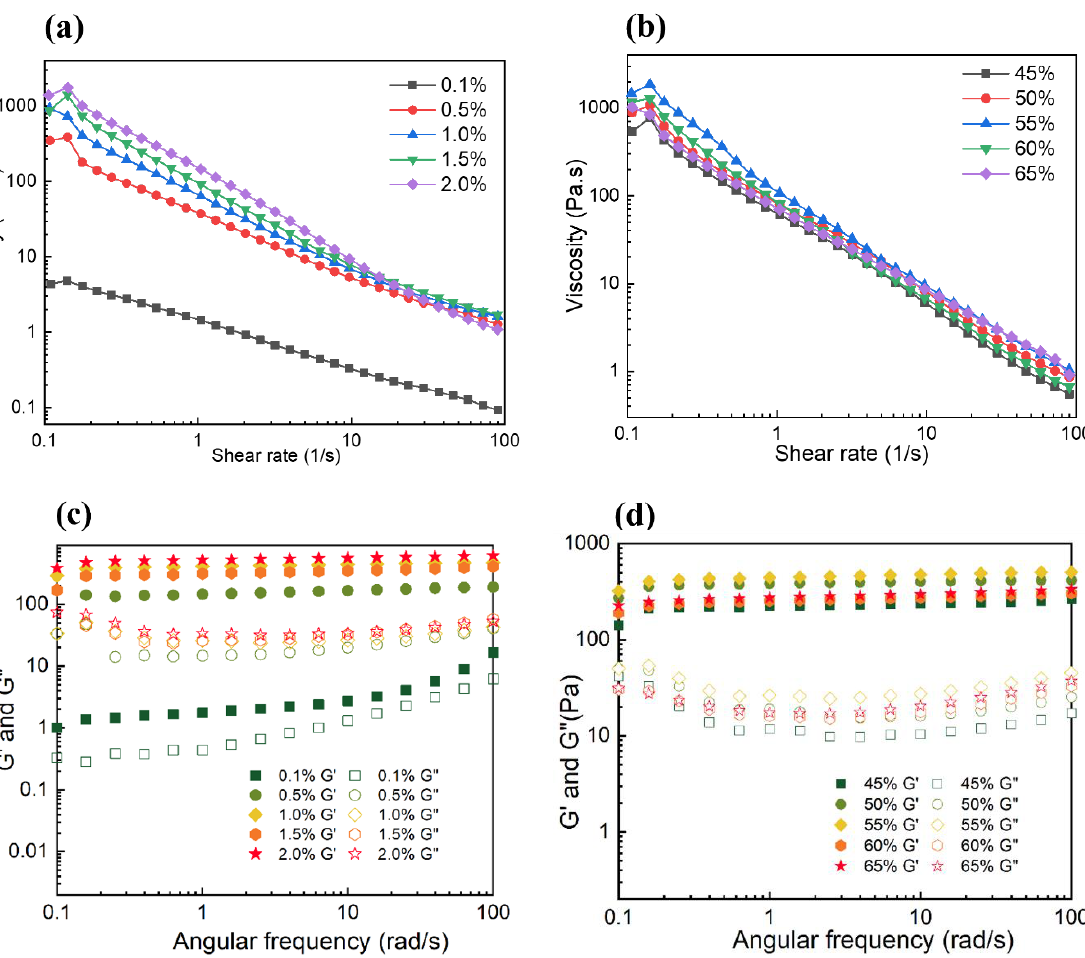
Figure 8. Apparent viscosity ( a , b ) and the dynamic rheological behavior ( c , d ) of Pickering emulsions under different particle concentrations ( a , c ) and oil fractions ( b , d ).